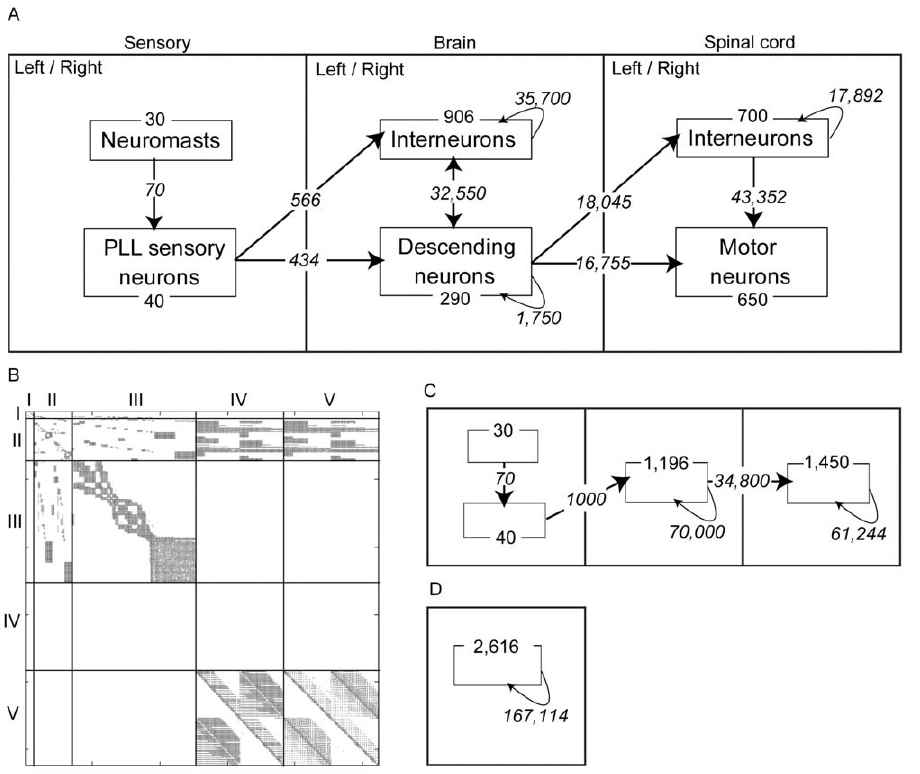
Figure 3. Graph structures, showing the numbers of nodes and connections. The outer squares represent processing compartments. Nodes are shown as rectangles within processing compartments, and node numbers are shown along the borders of those rectangles.Connections (edges) are shown as arrows, and connection numbers are shown near the respective arrows. The total number of nodes and connections is the same for all graphs. A. The zebrafish connectome graph model. This schematic does not show the many individual cell-to-cell connection rules that further distinguished the zebrafish graph. Left and right sides of the nervous system are shown together here to aid visualization, but in the actual graph they were distinct, and some connections were ipsilateral and others contralateral (see Table 1). B. Adjacency matrix for the zebrafish graph. Connections are from nodes in rows to nodes in columns. I=neuromasts and sensory neurons, II=descending neurons, III=brain interneurons, IV=spinal motor neurons, V=spinal interneurons. Spinal motor neuron nodes made no connections to other nodes so are not shown in the matrix. C. Structured random graph model. This test graph was the most similar to the zebrafish graph but did not have bilaterality or distinct node categories in brain or motor compartments. All permitted connections in this model were assigned randomly. D. The random graph. Any connection was permitted and all connections were assigned randomly.